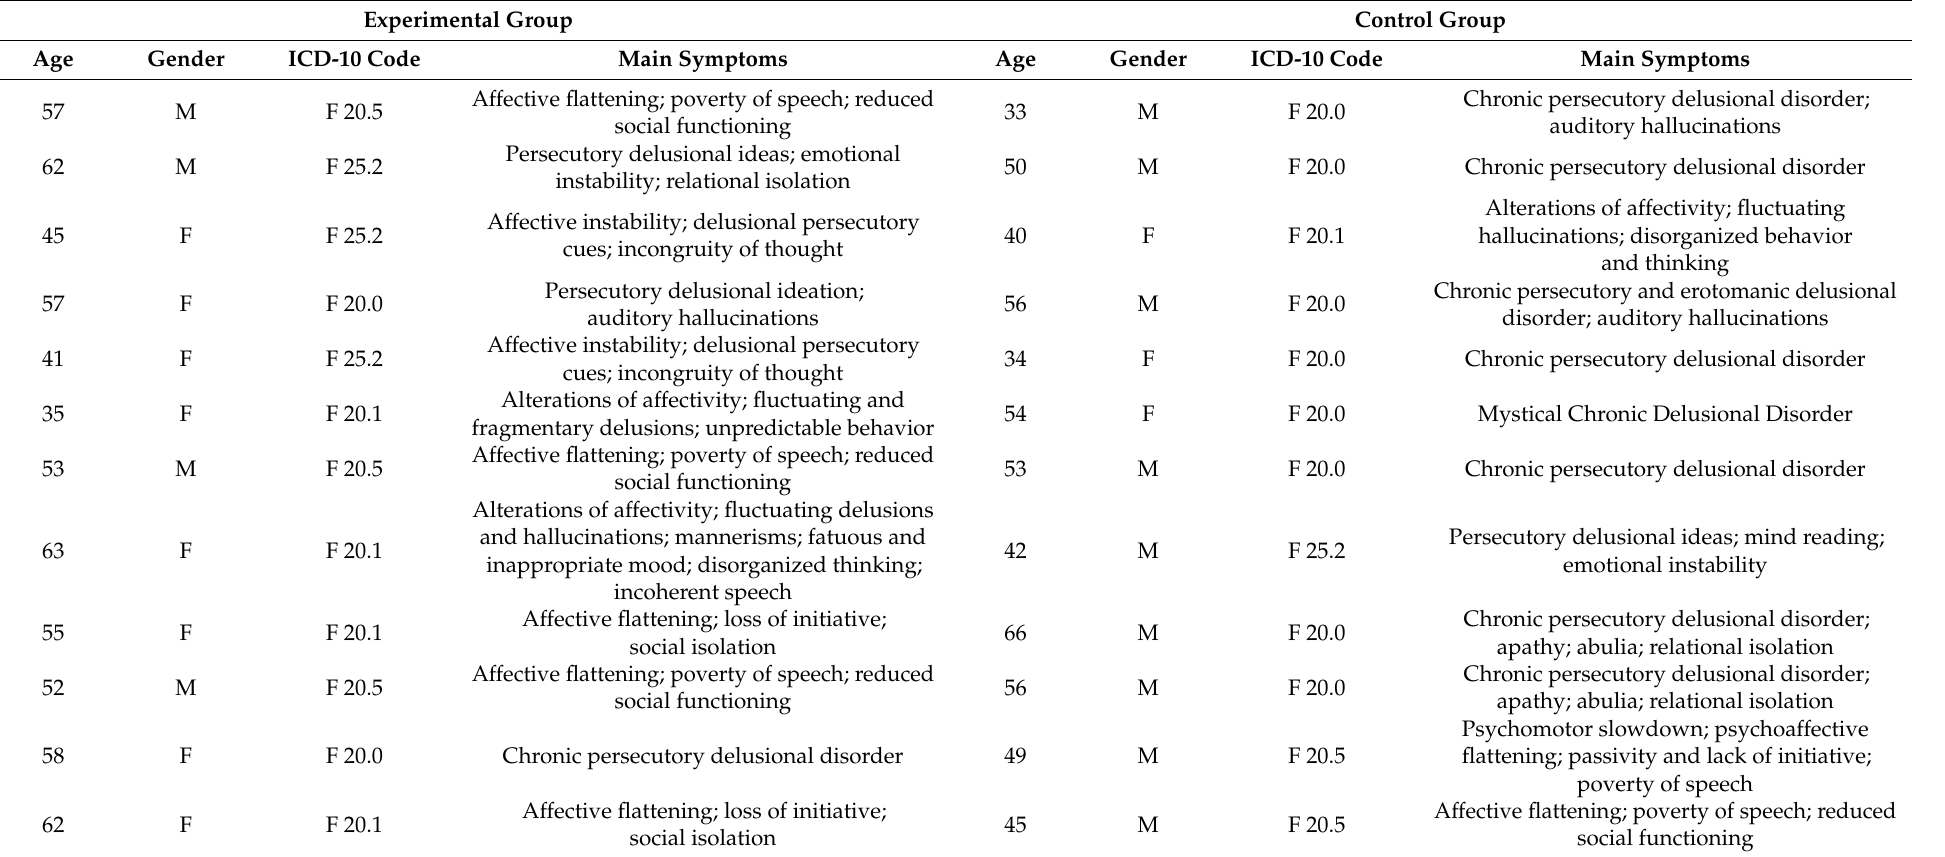
Table 1. List of participants, indicating the relative age, gender, ICD-10 code, and the main symptoms. Specifically, the codes pertaining to the participants are: (i) F20.0